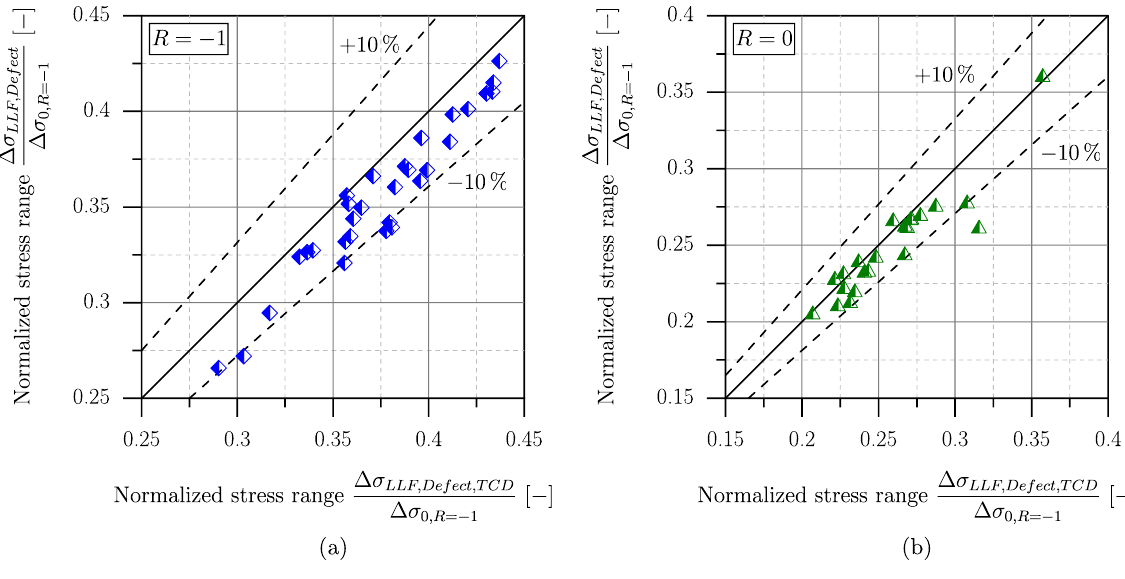
Figure 14. Comparison of SED- and TCD-based long-life fatigue assessment results: ( a ) R = − 1; and ( b ) R =